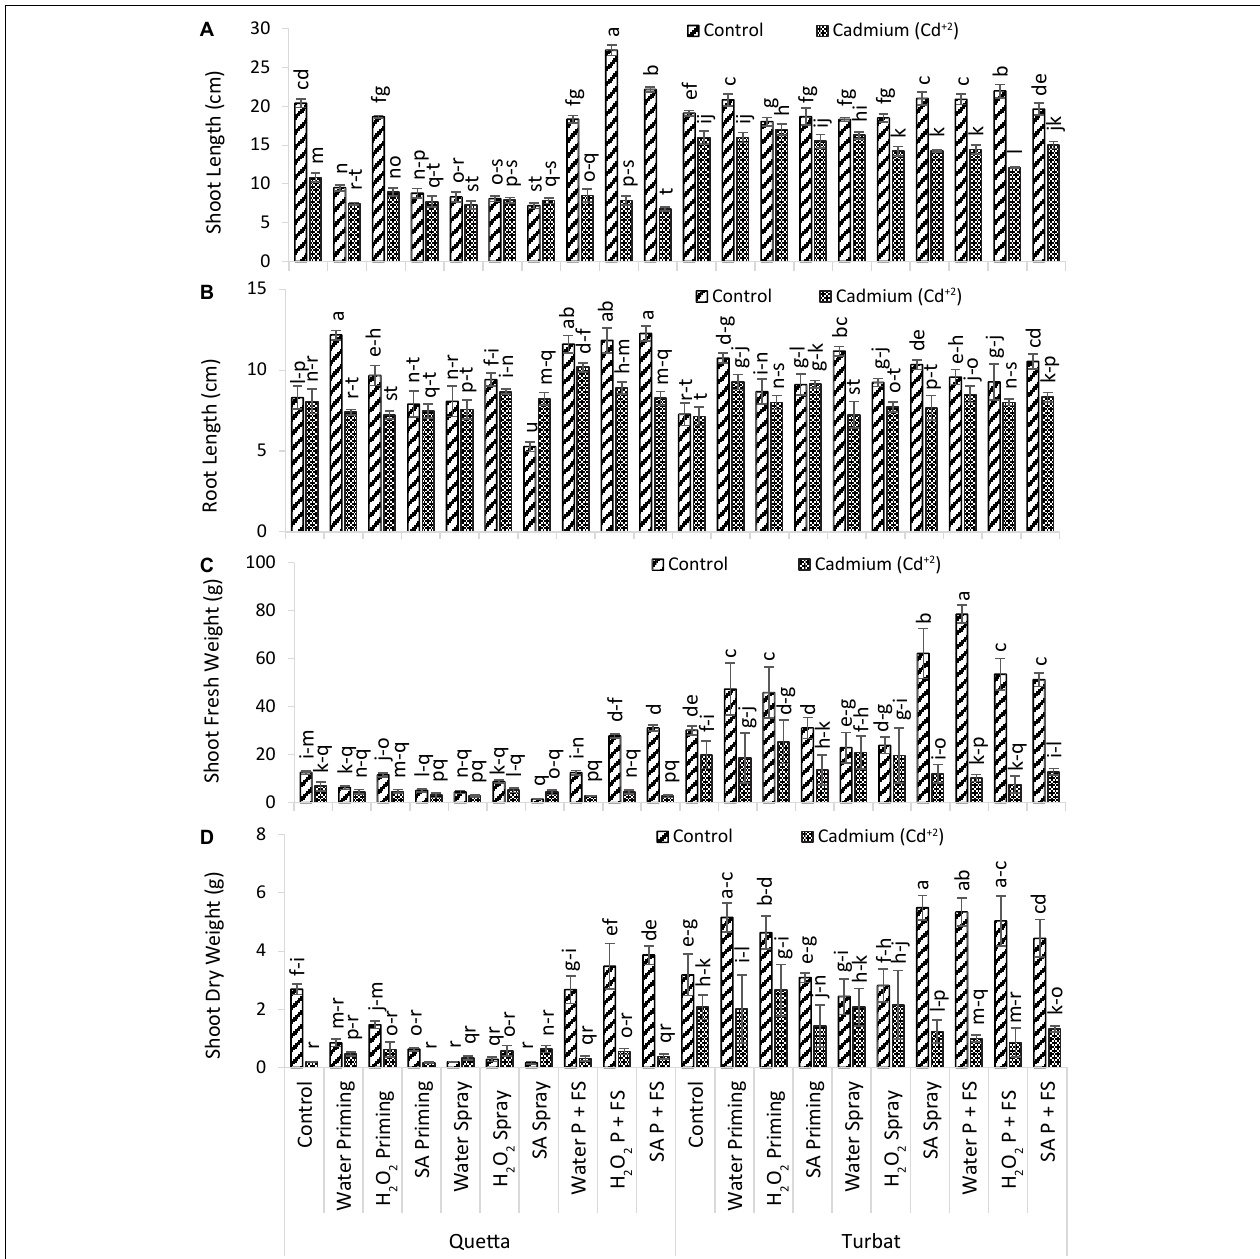
FIGURE 2 | Growth parameters; shoot length (A) , root length (B) , shoot fresh weight (C) , shoot dry weight (D) of milk thistle as affected by SA and H 2 O 2 treatment grown at Quetta and Turbat under cadmium stress. The same letters on graphs represent statistically similar effect ( p <